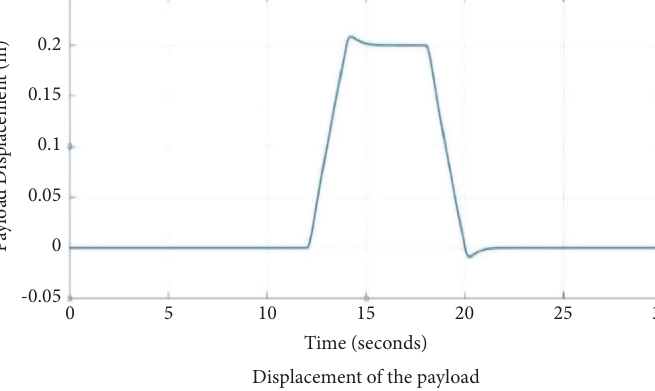
Figure 5: System response with the frst input